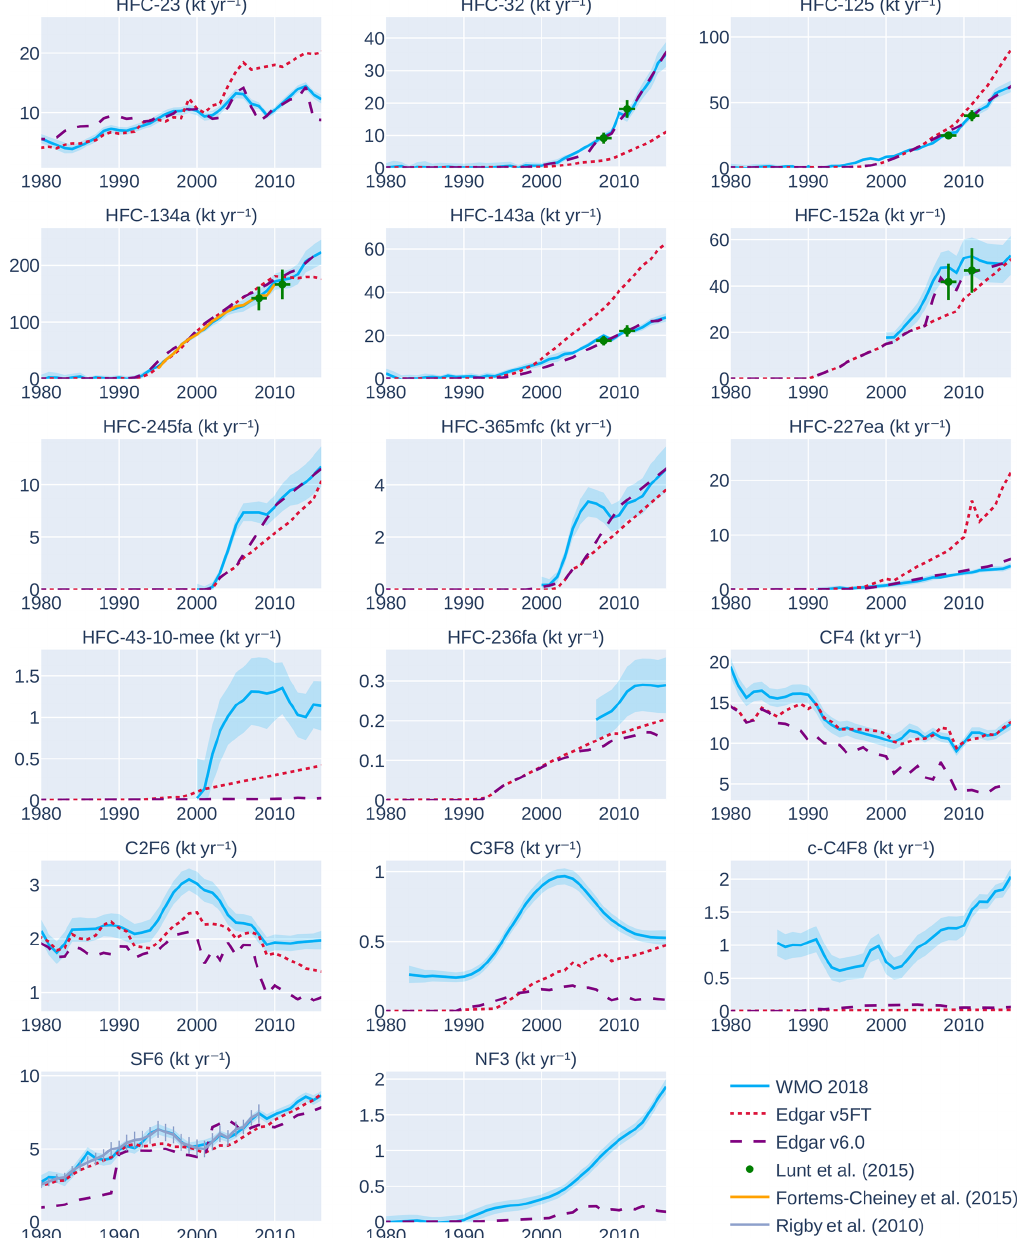
Figure 2. Comparison of top-down and bottom-up estimates for individual species of fluorinated gases in Olivier and Peters (2020) (EDGARv5FT) and EDGARv6 for 1980–2016. C 4 F 10 , C 5 F 12 , C 6 F 14 , and C 7 F 16 are excluded. Top-down estimates from WMO 2018 (Engel and Rigby, 2018; Montzka and Velders, 2018) are shown as blue lines with blue shading, indicating 1 σ uncertainties. Bottom-up estimates from EDGARv5 and EDGARv6 are shown in red dotted lines and purple dashed lines, respectively. Top-down estimates for some species are shown from Rigby et al. (2010), Lunt et al. (2015), and Fortems-Cheiney et al.